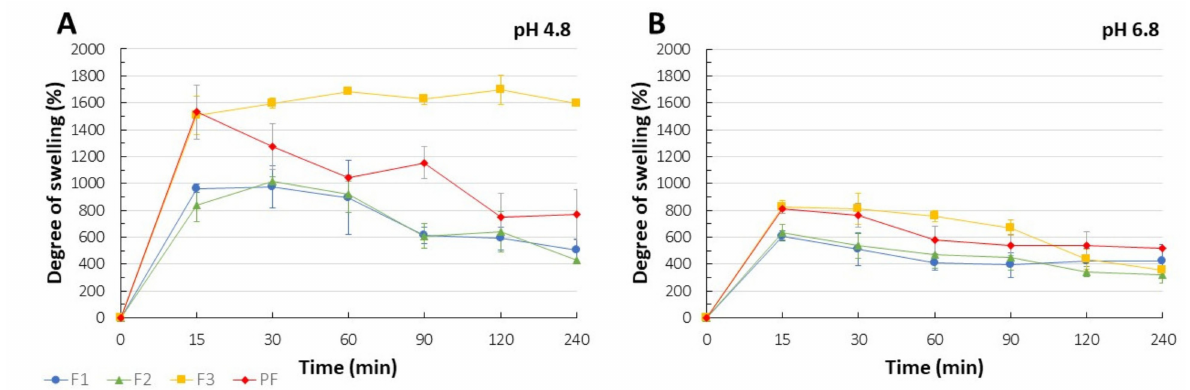
Figure 4. Swelling behavior of F1–F3 and placebo films (PF) in the SS with pH 4.8 ( A ) and pH 6.8 ( B ) at 37.0 ± 0.5 ◦ C presented by using the degree of swelling (mean ± SD, n =